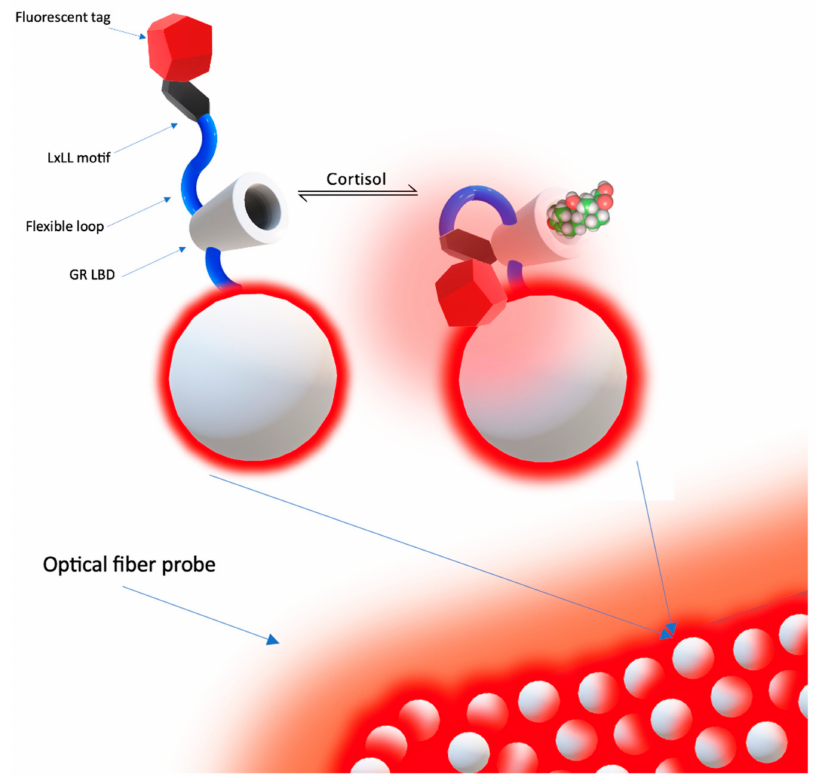
Figure 12. Intermolecular equilibrium binding of the proposed single-molecule metal-enhanced fluorescent assay on the polymer optical fiber toward the in vivo monitoring of